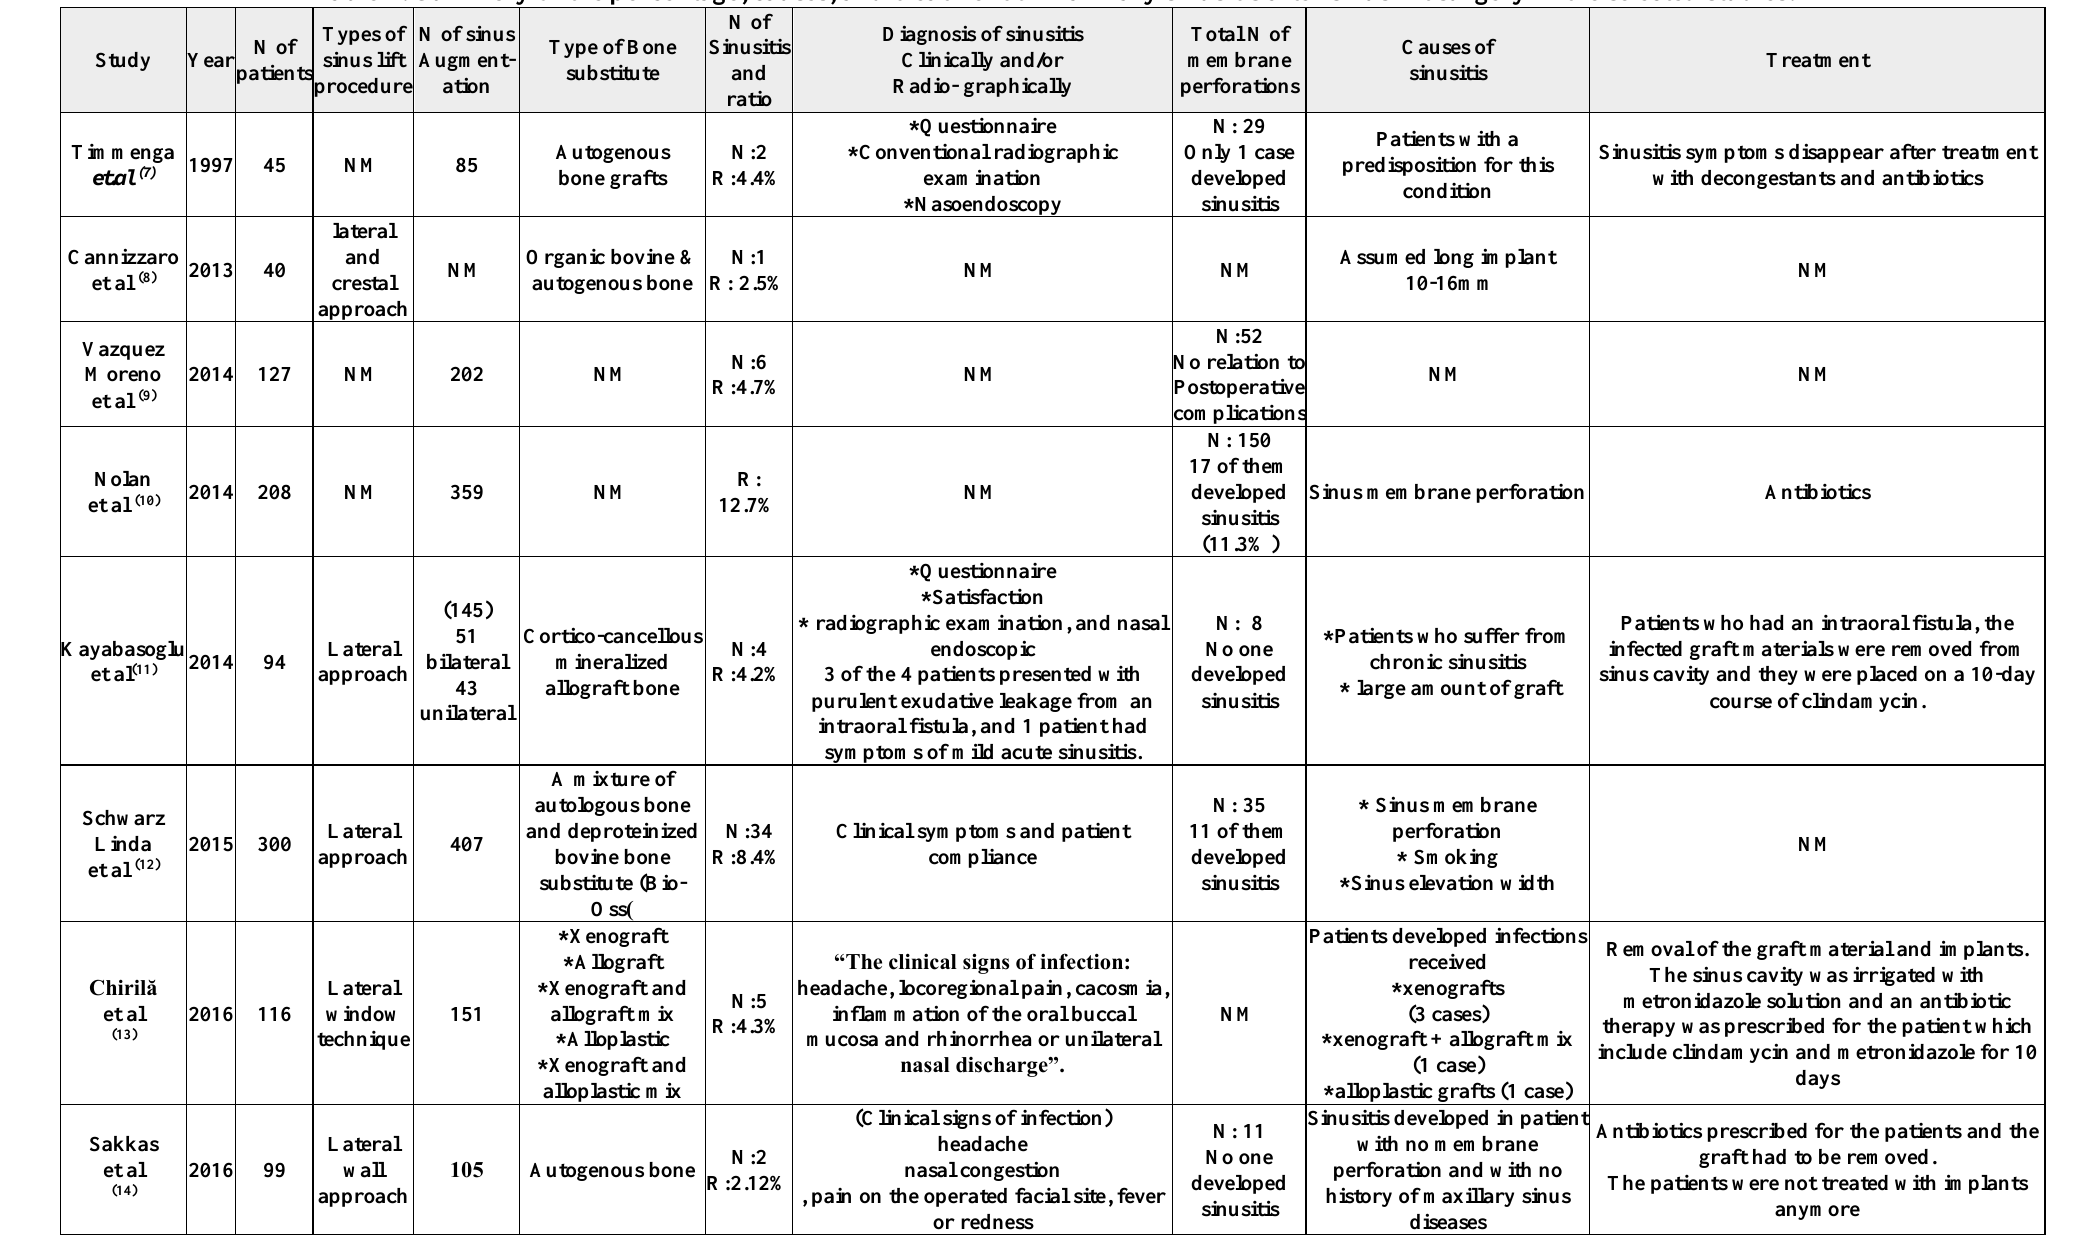
Table 1: Summery of the percentage, causes, and treatment of maxillary sinusitis after sinus lift surgery in the selected studies.